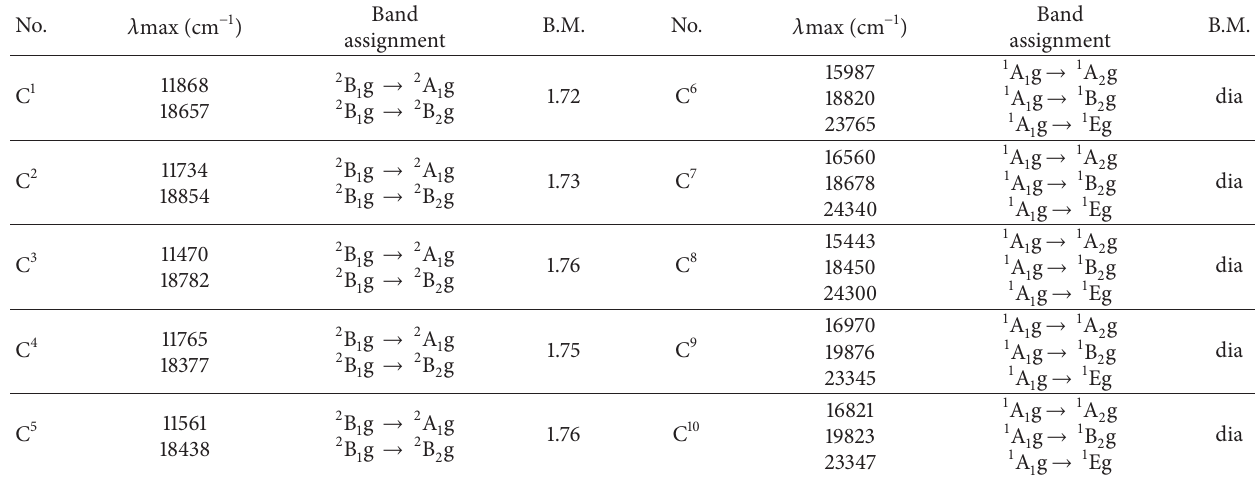
Table 1: Electronic spectra and magnetic moments of metal(II)